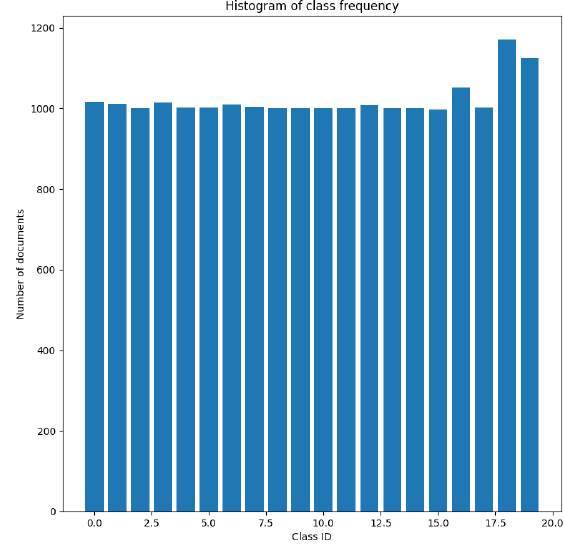
Figure 14. Class frequency distribution for 20Newsgroups.